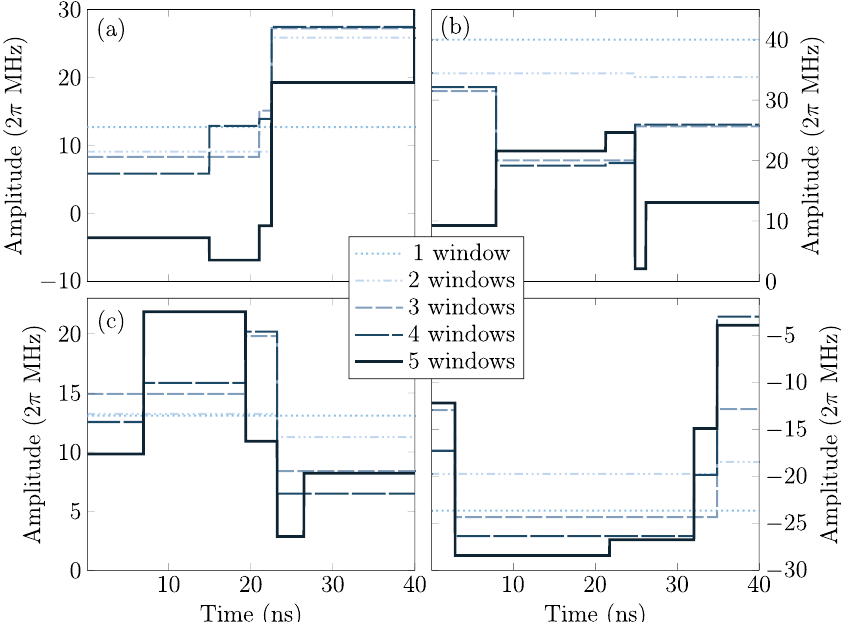
Fig. 9 Adaptive pulse sequences for LiH molecule. Square pulse shapes obtained at each adaptive step, starting from one time window and adaptively dividing the time window up to fi ve-segments. The accuracy increases with each division of the pulse. Pulse shapes are shown for the pulses on a qubit 1, b qubit 2, c qubit 3, d qubit